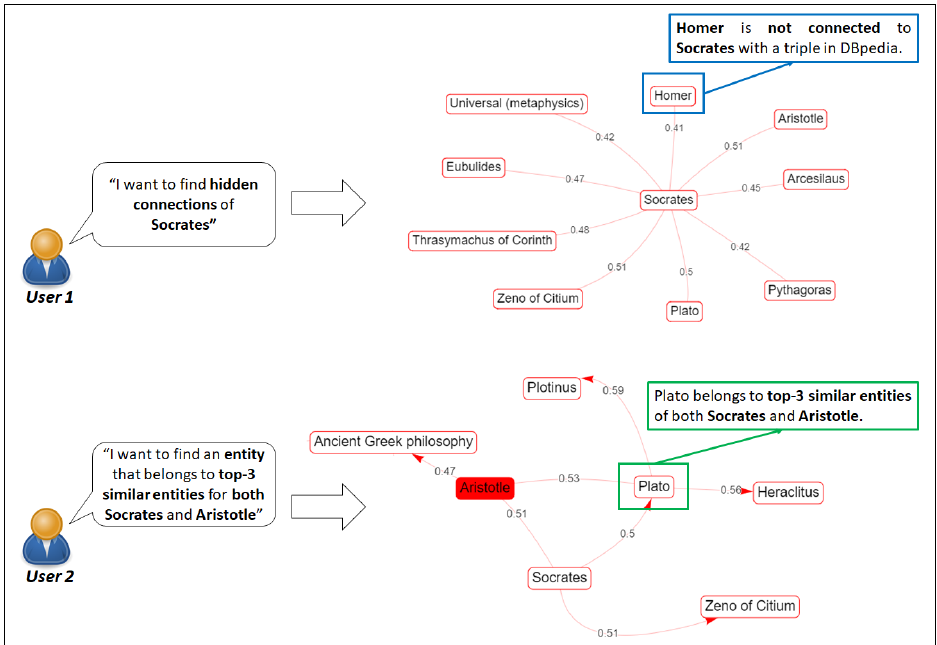
Figure 14. Discovering “Hidden” Similarity-Based Connections between